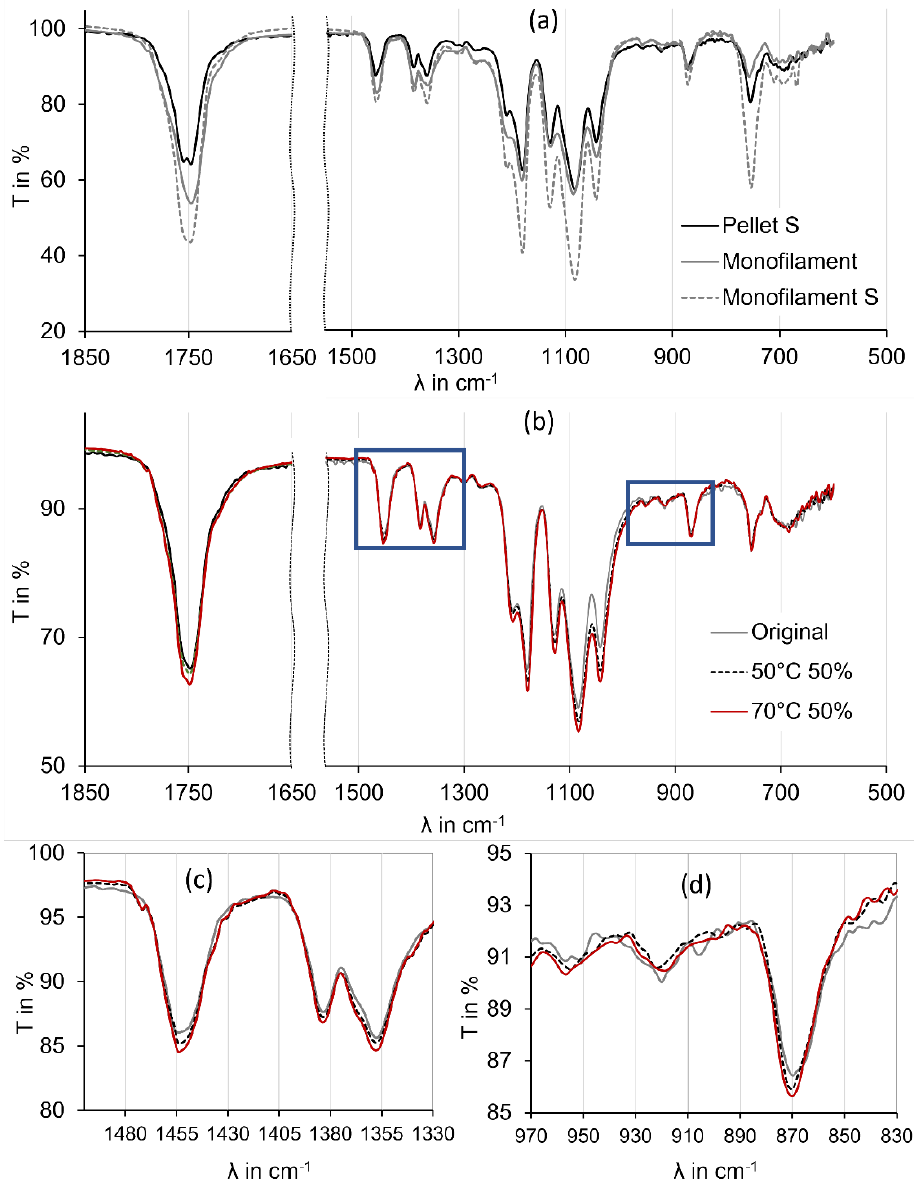
Figure 7. FTIR spectra of PLA materials: ( a ) monofilament as fabricated and cast from solution (S) and cast film of pellet material of the same grade; ( b – d ) as prepared (original) and artificially aged nonwoven NW-L under indicated conditions. Rectangles in ( b ) mark the enlarged areas of spectra displayed in ( c , d ).